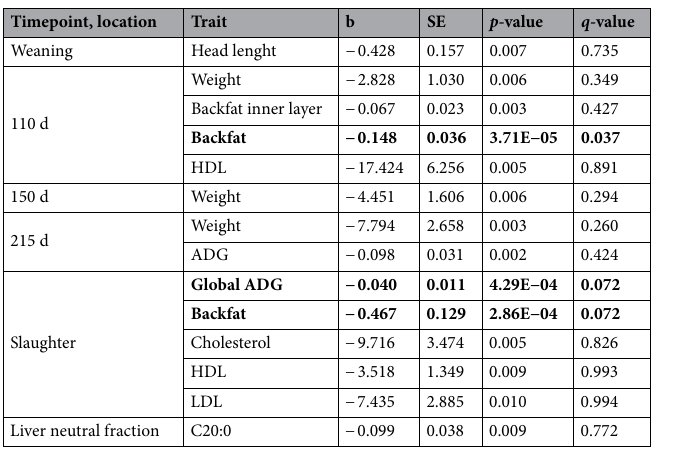
Table 3. Association results for LEPRc .1987C/T polymorphism (001_LEPR, position 146,829,589). Traits with p‑ value < 0.01 are shown and those with q < 0.10 are highlighted in